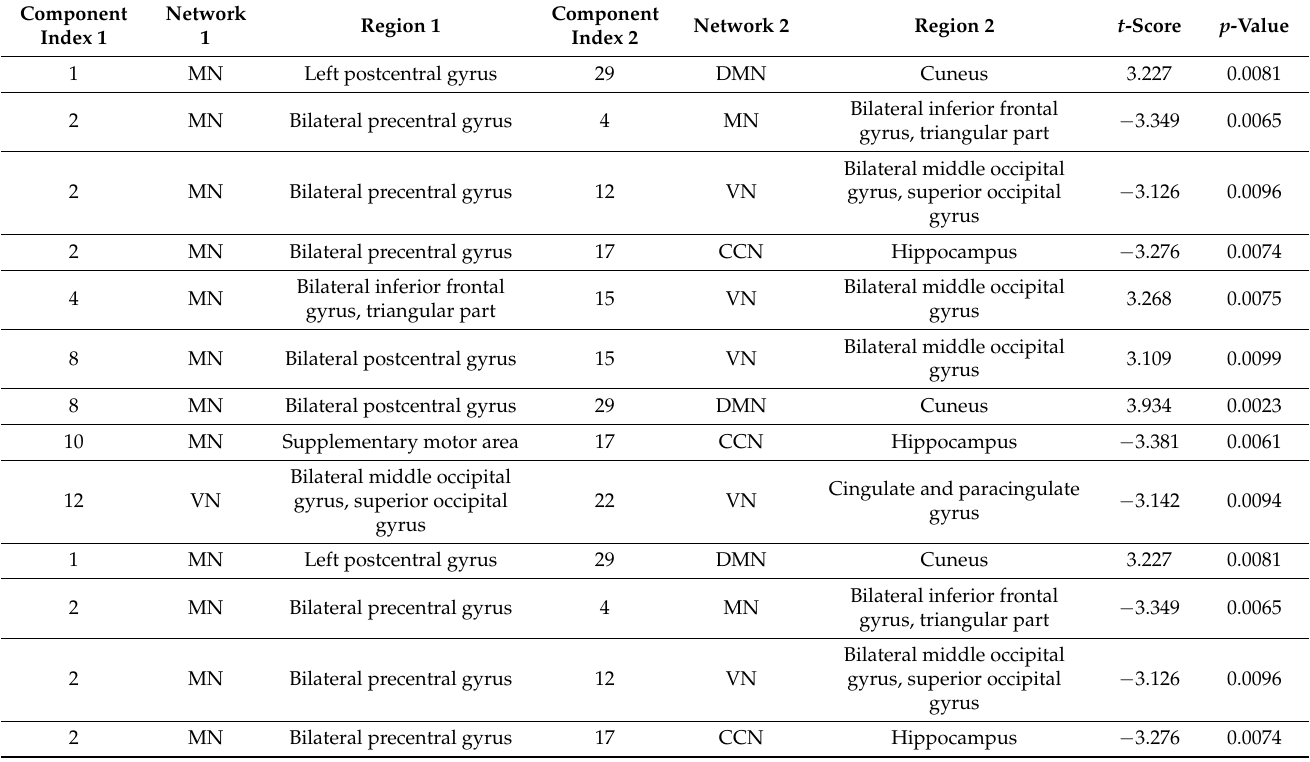
Table 2. Statistics and specific brain locations of connections that survived the NBS approach in state 6 of the control group for the post-training run versus the pre-training